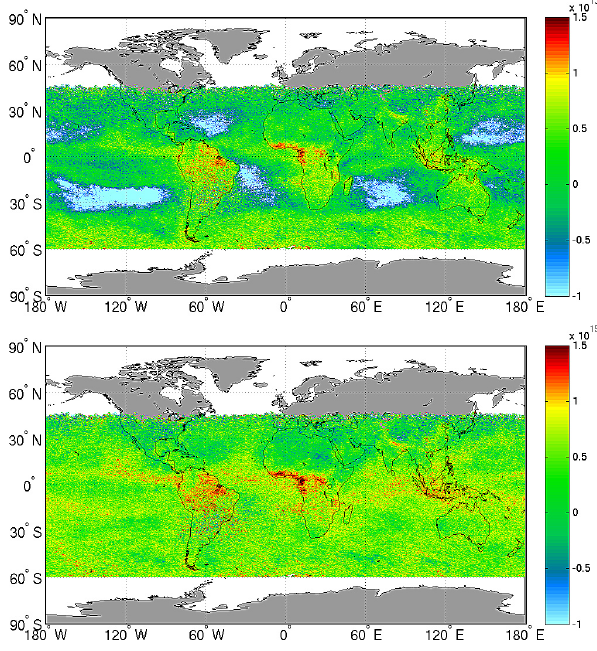
Fig. 2. Monthly mean of glyoxal SCDs (molec/cm 2 ) measured by GOME-2 in December 2008. The upper and lower panels respec- tively show the columns retrieved without and with the liquid water absorption included in the DOAS fit. Pixels in polar regions and/or with solar zenith angles larger than 70 ◦ have been